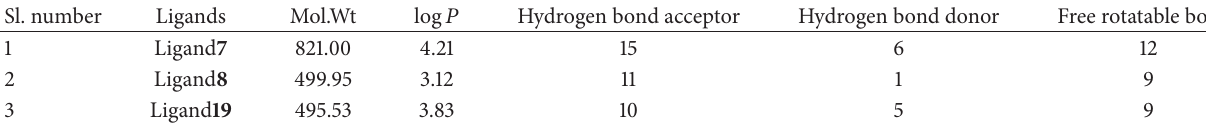
Table 8: Properties of ligand molecules.